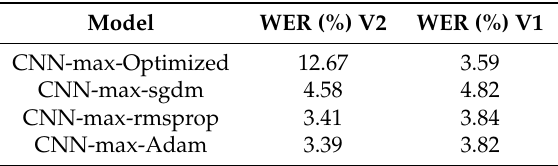
Table 9. WER of models with different training options and the optimization function trained and tested on clean data.